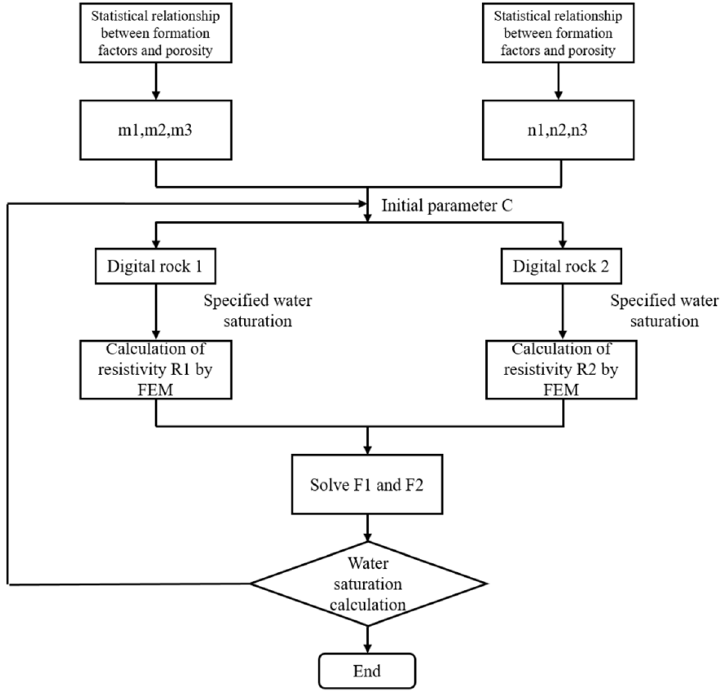
Figure 23. Relationship between resistivity index and saturation.